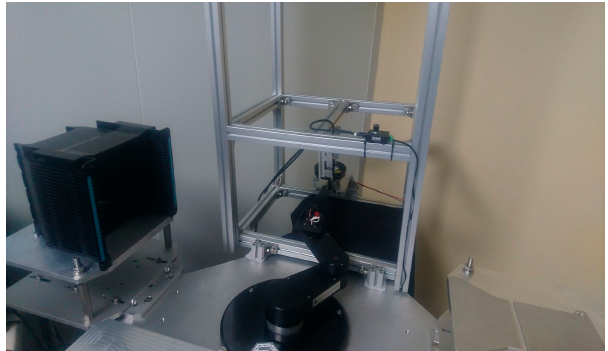
Figure 4. Picture of the WHRA and add-on charge-coupled device (CCD).